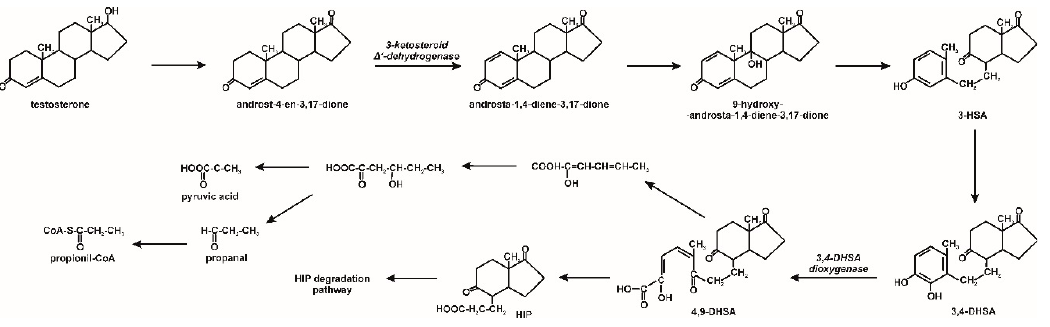
Figure 4. Testosterone biodegradation by bacteria in aerobic conditions; 3-HSA–3-hydroxy-9,19-seco- androsta-1,3,5(10)-triene-9,17-dione; 3,4-DHSA–3,4-dihydroxy-9,10-seco-androsta-1,3,5(10)-triene- 9,17-dione; 4,9-DHSA–3-hydroxy-5,9,17-trioxo-4,5-9,10-diseco-androsta-1(10),2-diene-4-oic acid;